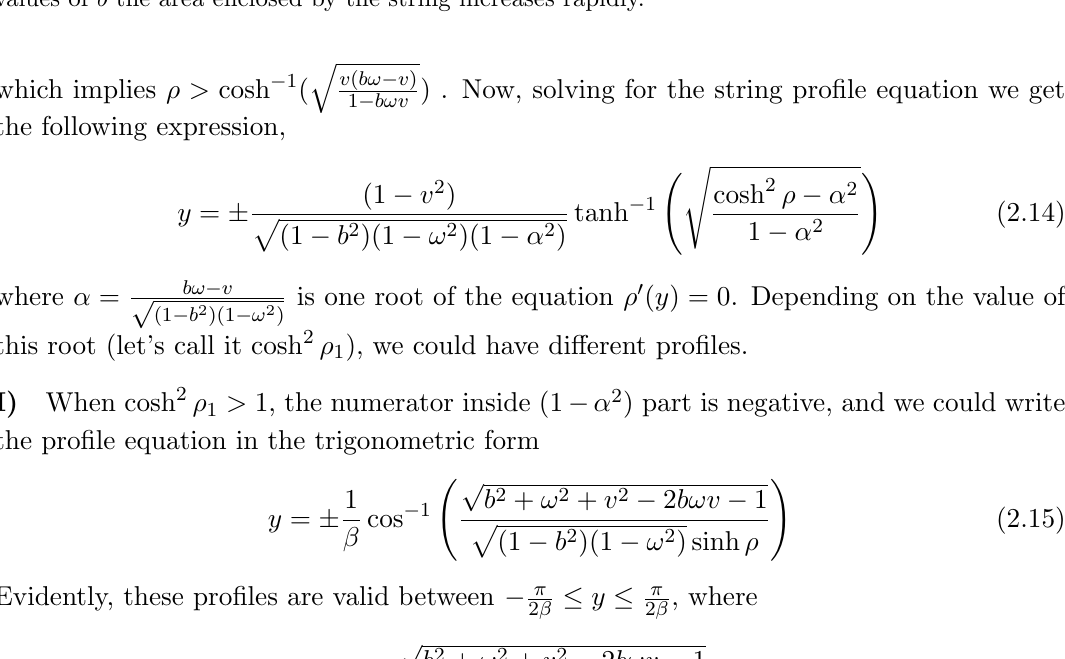
Figure 1. Plot of hanging string pro(cid:12)les with ! = 0 : 8 and v = 0 : 93, notice that with increasing values of b the area enclosed by the string increases